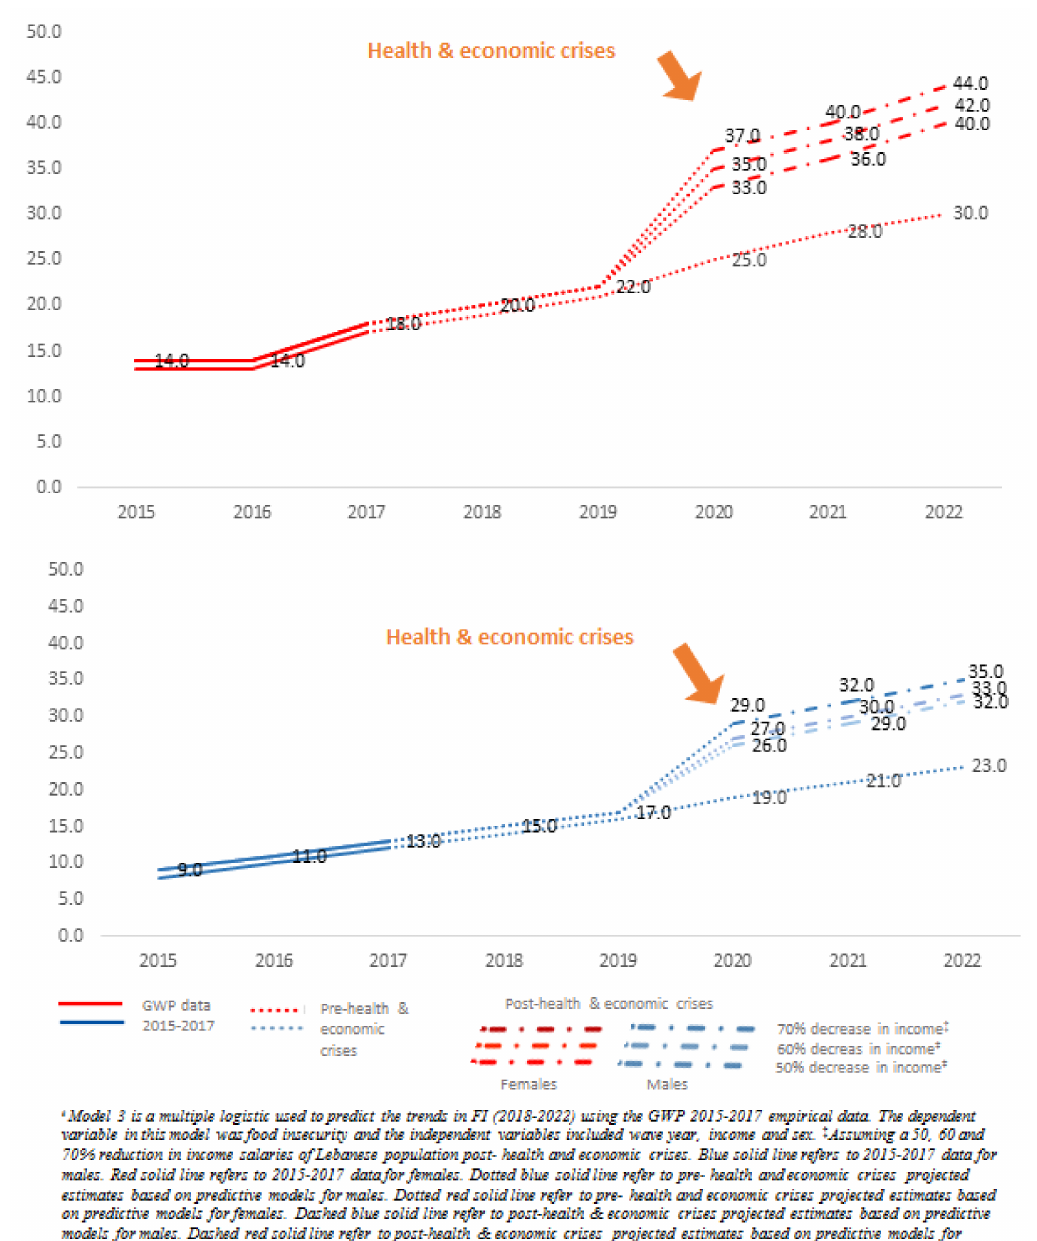
Figure 1. Trends and projections of FI (2018–2022) among Lebanese adult population using model 1 ŧ (including wave Figure 3. Projections of FI (FI) prevalence among Lebanese adults by sex, using model 3